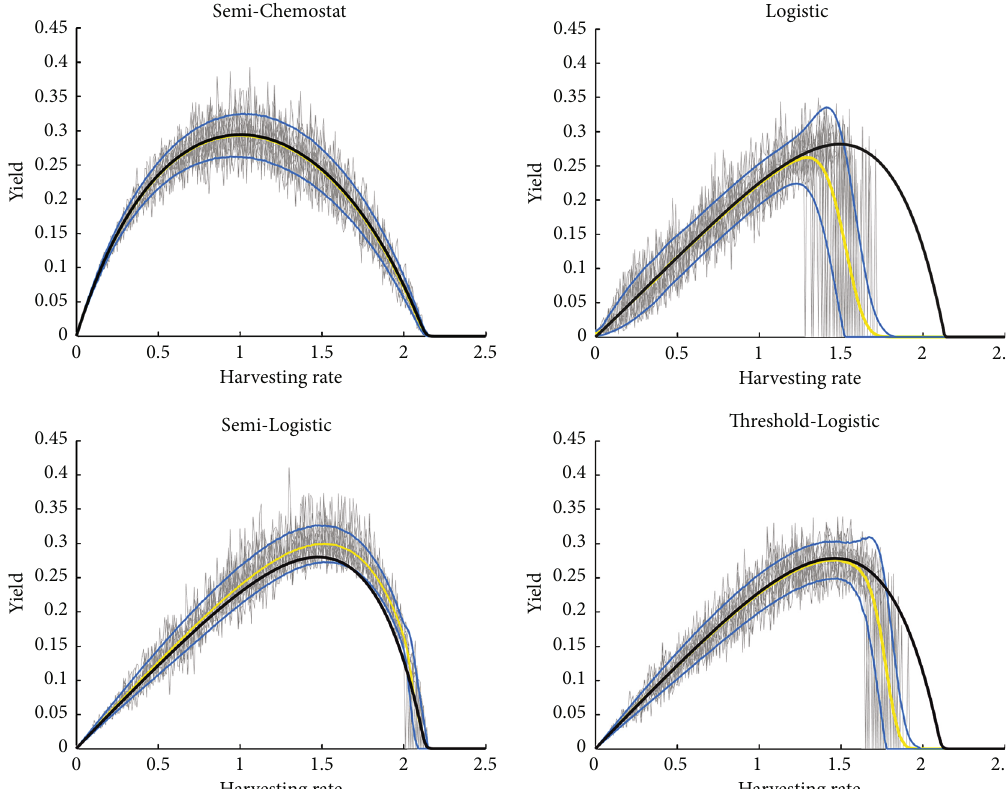
Figure 6: The yield of semichemostat, logistic, semilogistic, and threshold-logistic growth rates at steady state w.r.t. harvesting rate. The grey trajectories show the yield from di ff erent simulations for the stochastic case. The yellow curve represents the yield mean value of the simulations. The light blue curves represent the interval of standard deviation (68%) of the yield. The black curve represents the yield for the deterministic